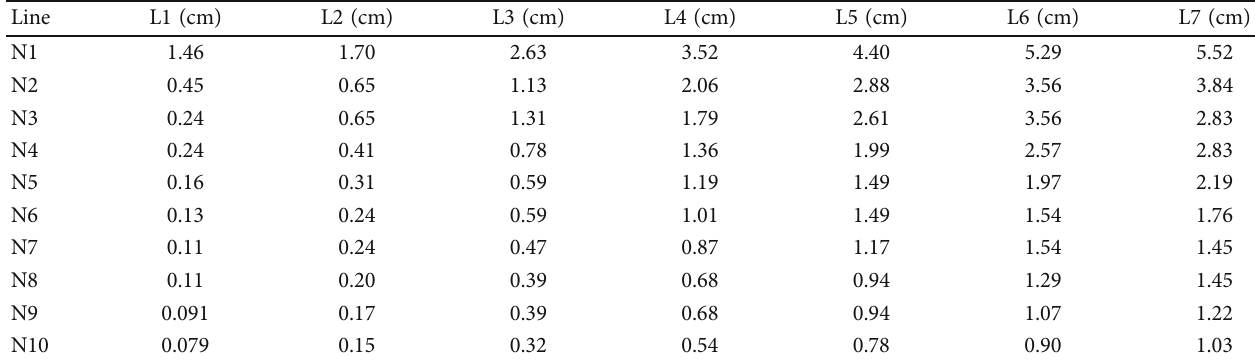
Table 5: The radial displacements of each survey line.